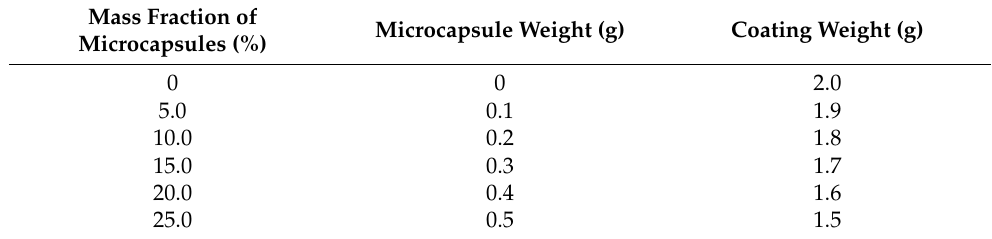
Table 4. Experimental material list.